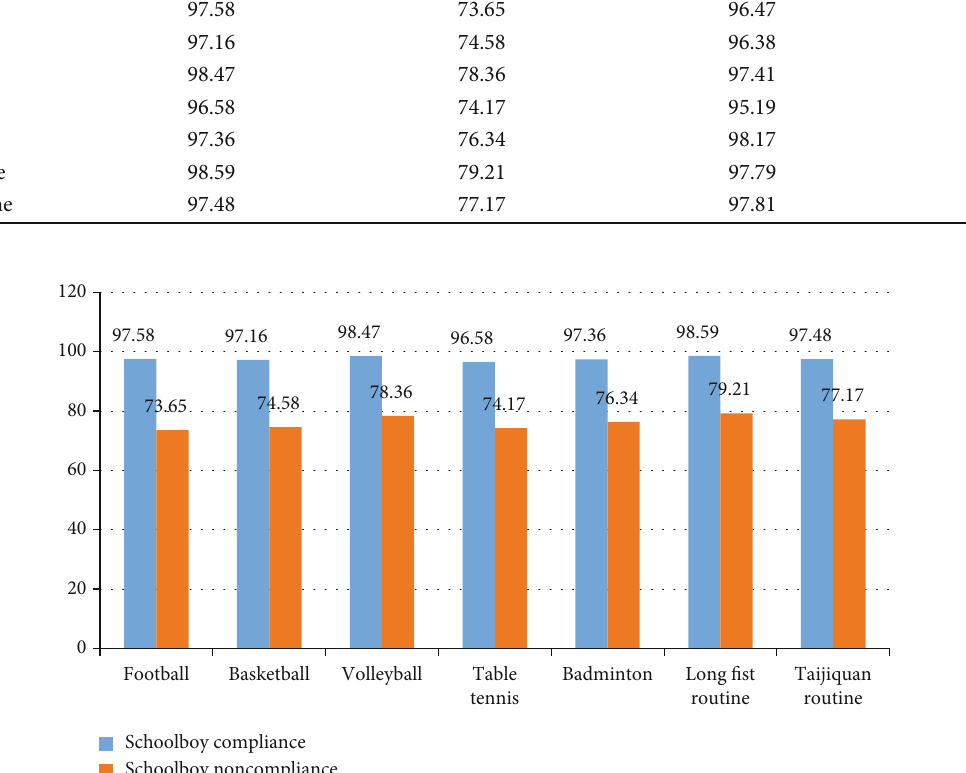
Figure 3: Comparison of physical fi tness test compliance rate of boys in di ff erent groups.